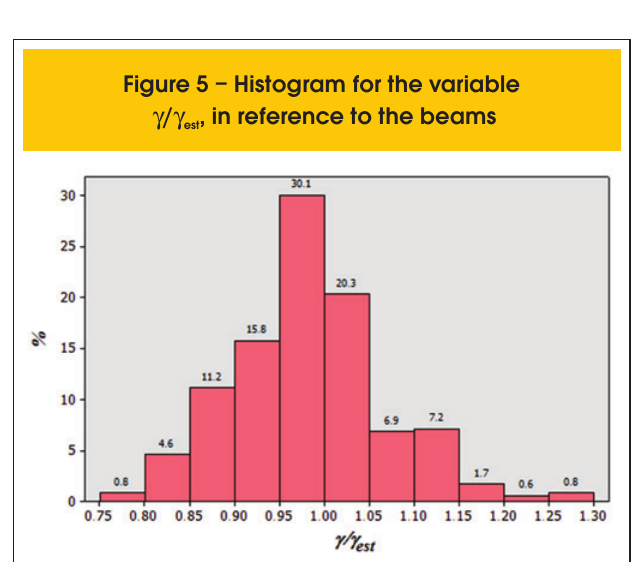
Figure 4 – Histogram for the variable g / g , in reference to the columns